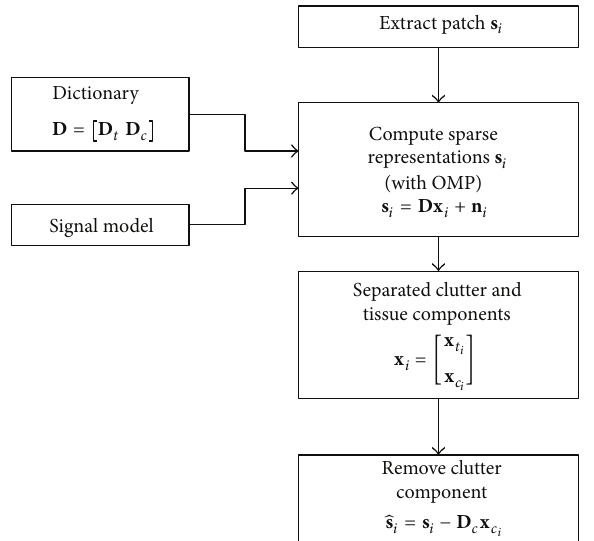
Figure 2: Block diagram of Morphological Component Analysis for clutter reduction for a signal patch s 𝑖